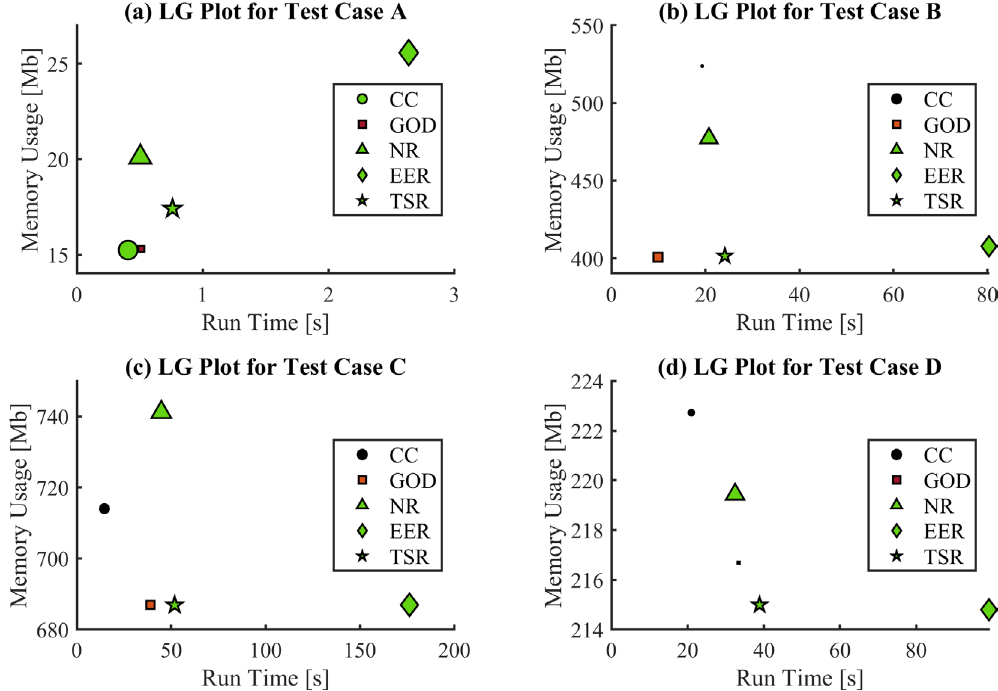
Figure 17. SGL plots for each test